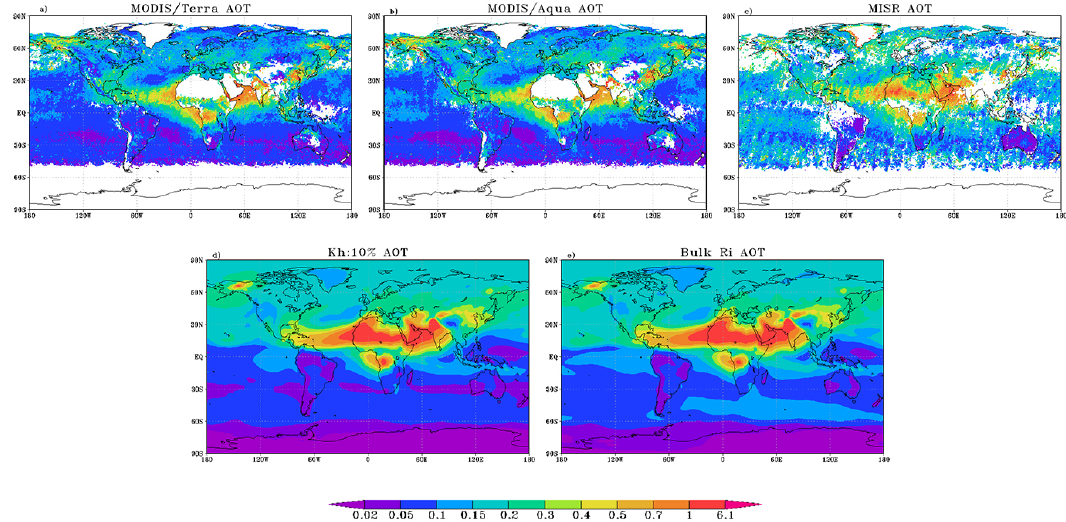
Figure 12. July 2009 monthly mean aerosol optical thickness observations from the MODIS instruments on the Terra (global mean = 0.1277, standard deviation = 0.0645; a ) and Aqua (global mean = 0.1339, standard deviation = 0.0750; b ) satellites and from the MISR (global mean = 0.1808, standard deviation = 0.0617; c ) instrument on Terra. Monthly average aerosol optical thickness simulated by the GEOS- 5 model using the turbulent eddy diffusion coefficient method and a threshold of 10% of the column maximum (Method 2, global mean = 0.1943, standard deviation = 0.0774; d ) and the bulk Richardson number method (Method 3, global mean = 0.2153, standard de- viation = 0.0880; e ).